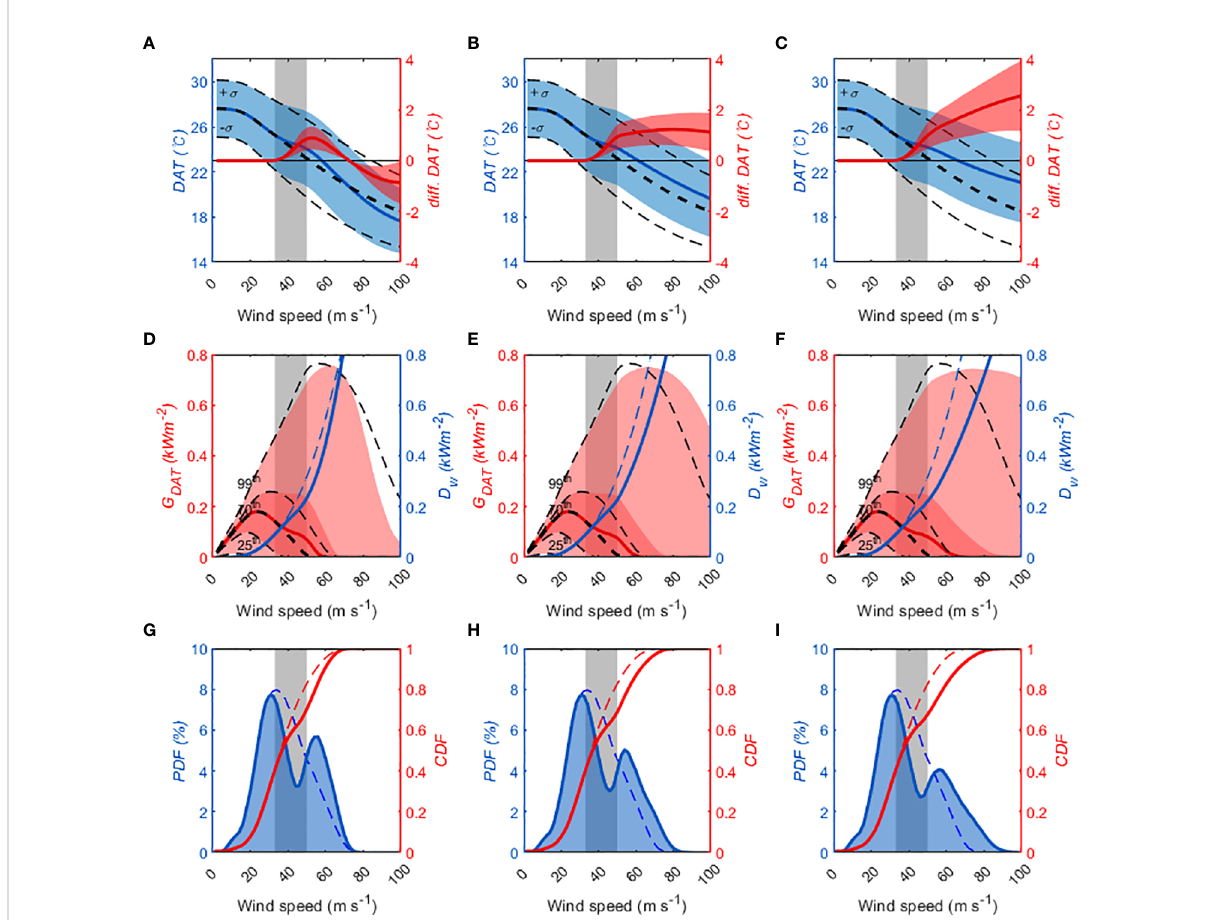
FIGURE 3 (A – C) The distribution of the depth-averaged temperature (DAT) and difference between D04 and each experiment: IC (left panels), FTL (center panels) and DC (right panels). The blue solid line and thick black dashed line indicate mean of DAT for each experiment and D04, respectively. The red solid line is the mean difference between D04 and each experiment. The shaded areas and black dashed lines indicate ±1 s intervals. (D – F) The distribution of the depth-averaged temperature-based energy generation ( G DAT ) and frictional dissipation ( D w ). The red solid line and thick black dashed line indicate the median of Gdat for each experiment and D04, respectively. The red shaded areas and black dashed lines indicate percentiles (25th, 70th, 99th) of Gdat for each experiment and D04, respectively. (G – I) The distribution of the cumulative distribution functions (red lines) and probability density functions (blue lines) of maximum potential intensity (MPI). The dashed lines represent the results of D04 and solid lines indicate the results of the three experiments. The probability density function of MPI is smoothed with a window width of 4 m s − 1